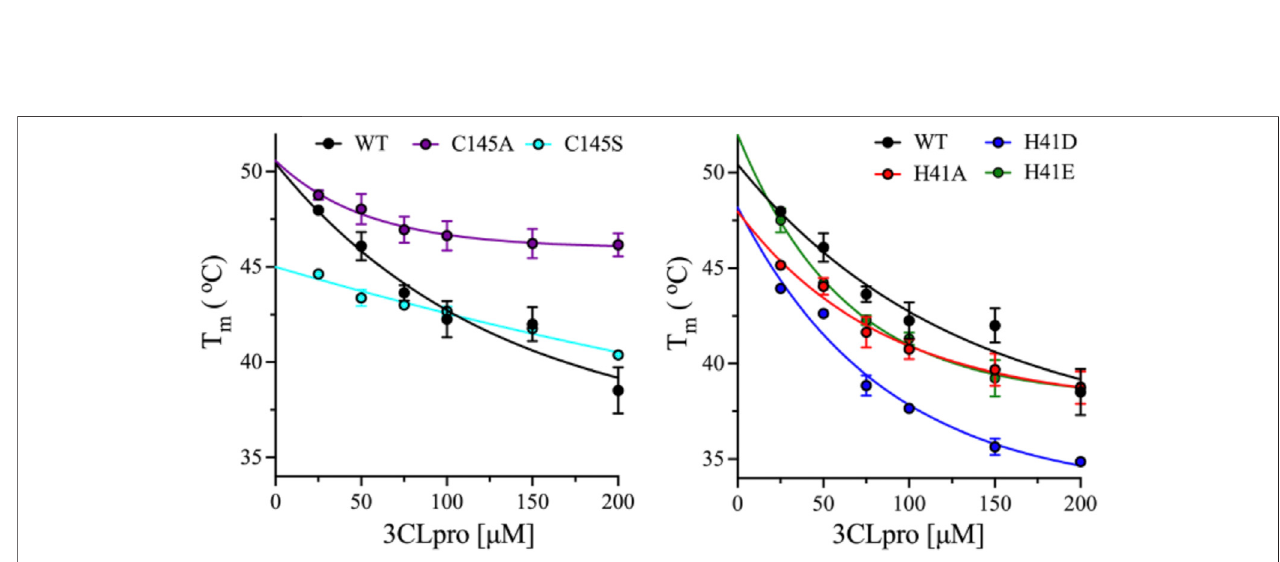
FIGURE6| Effectofenzymeconcentrationonthermalstabilityof3CLprovariants.Plotsof T m calculatedfromtheDSFthermalscansof3CLproatdifferentenzyme concentrations from 25 to 200 μ M. Data are presented as the mean + SD from, n (cid:2) 4.